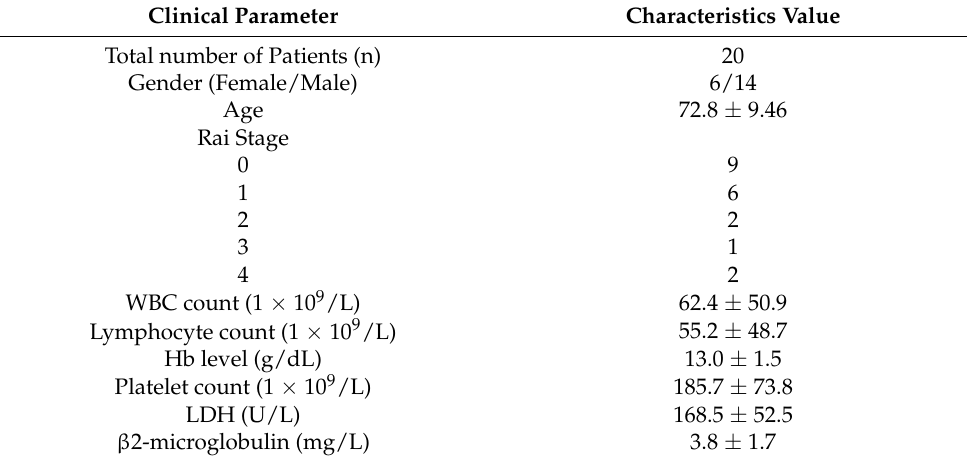
Table 1. Patients’ characteristics. Clinical